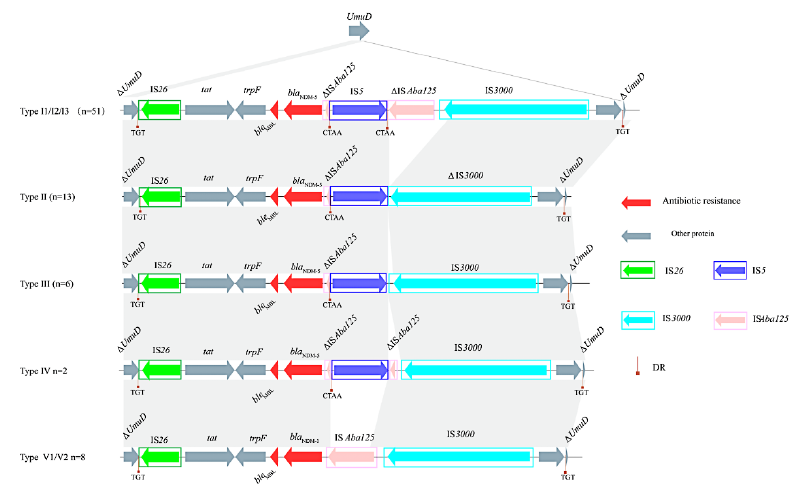
Figure 5. Comparison of the genomic genetic environment of bla NDM genes in IncX3. The arrows marked the direction of gene transcription, and the gene categories were differentiated by colors. The homologous regions were marked by grey shading. Table 2. Gene mutation sites of blaNDM-IncX3 plasmids *.